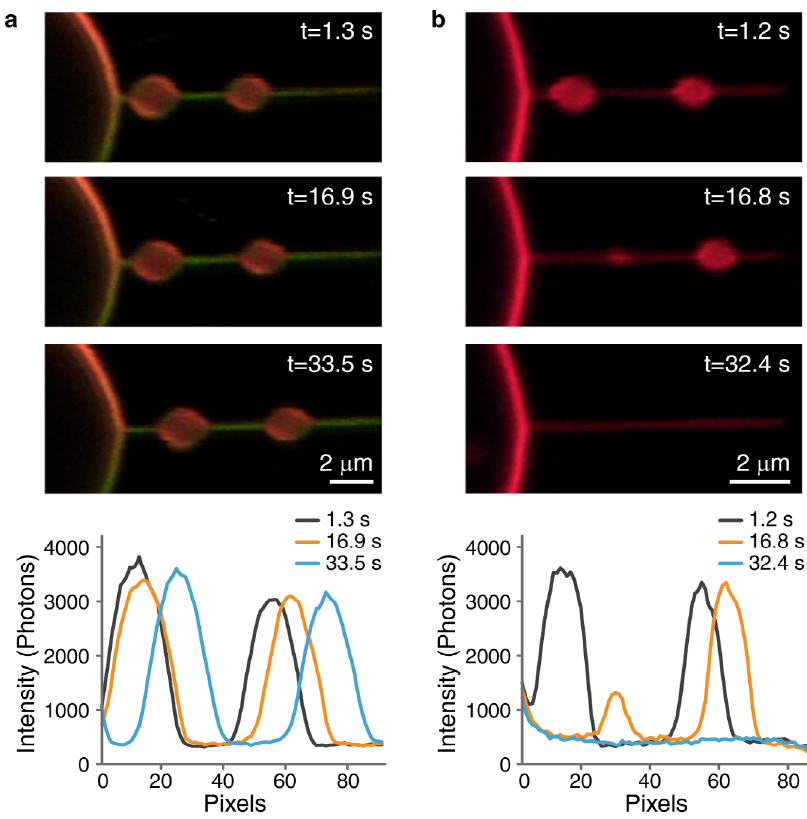
4 σ = ð 5 : 0±0 : 1 Þ ×10 (cid:2) 5 N = m. At the bottom: fl uorescence intensity pro fi les of DiI- C12 along the membrane tube and swellings at the indicated